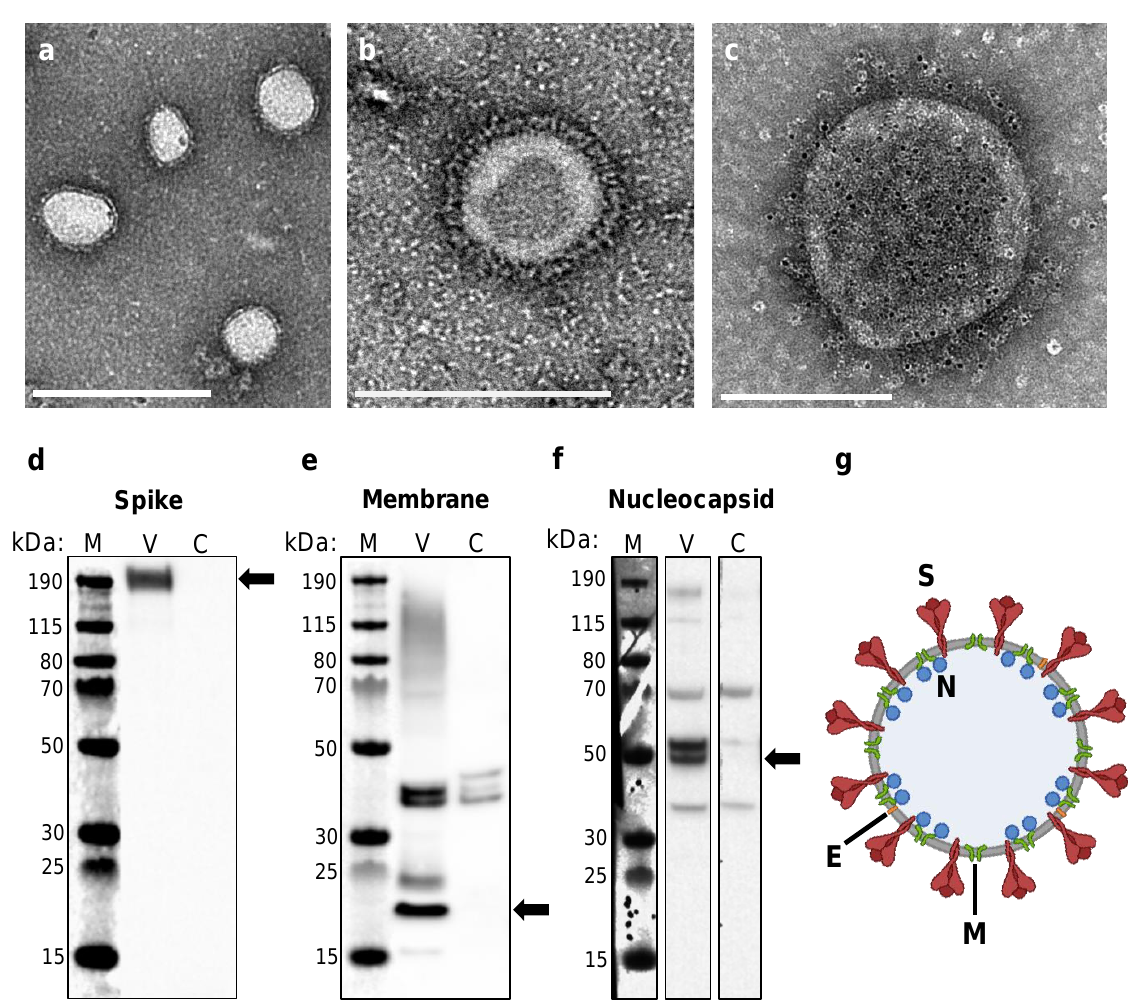
Figure 1. Construction of SARS-CoV-2 VLP vaccines . ( a , b ) Electron micrographs of purified SARS- CoV-2 VLPs negatively stained with phosphotungstic acid. Scale bars are 500 nm and 200 nm in ( a ) and ( b ), respectively. ( c ) Immunogold-labeled electron micrograph generated using an anti-spike primary antibody and gold-bead labeled secondary antibody. Gold beads appear as small black dots, ~6 nm in diameter. Scale bar 200 nm. ( d – f ) Western blot analysis of purified VLPs (V) and mock transfected cell lysate as a negative control (C) generated using an ( d ) anti-spike antibody, ( e ) anti-membrane antibody, and ( f ) anti-nucleocapsid antibody. The sizes of the molecular weight markers (M) are labeled to the left of each blot. Arrows indicate the protein of interest for each blot. Full images of each blot are shown in Figure S2. ( g ) Schematic of a SARS-CoV-2 VLP, containing all four structural proteins (S, E, M, and N) and devoid of genetic material.